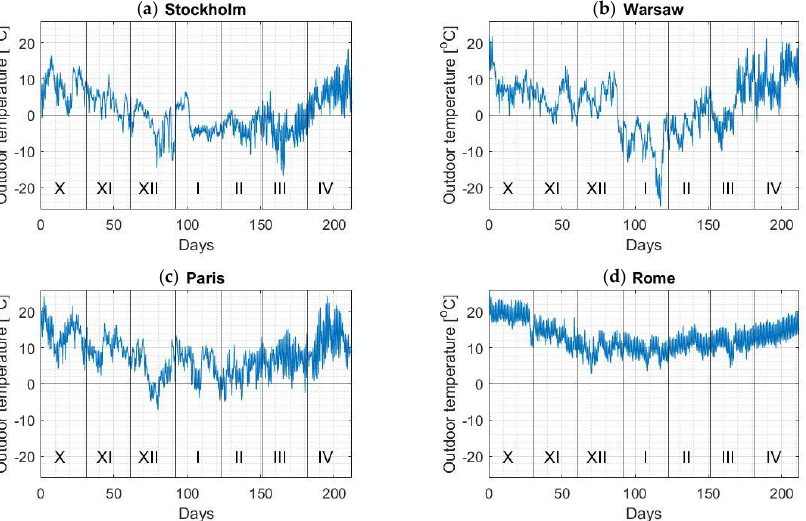
Figure 5. Outdoor temperature during the heating period (on the basis of data from [44]).